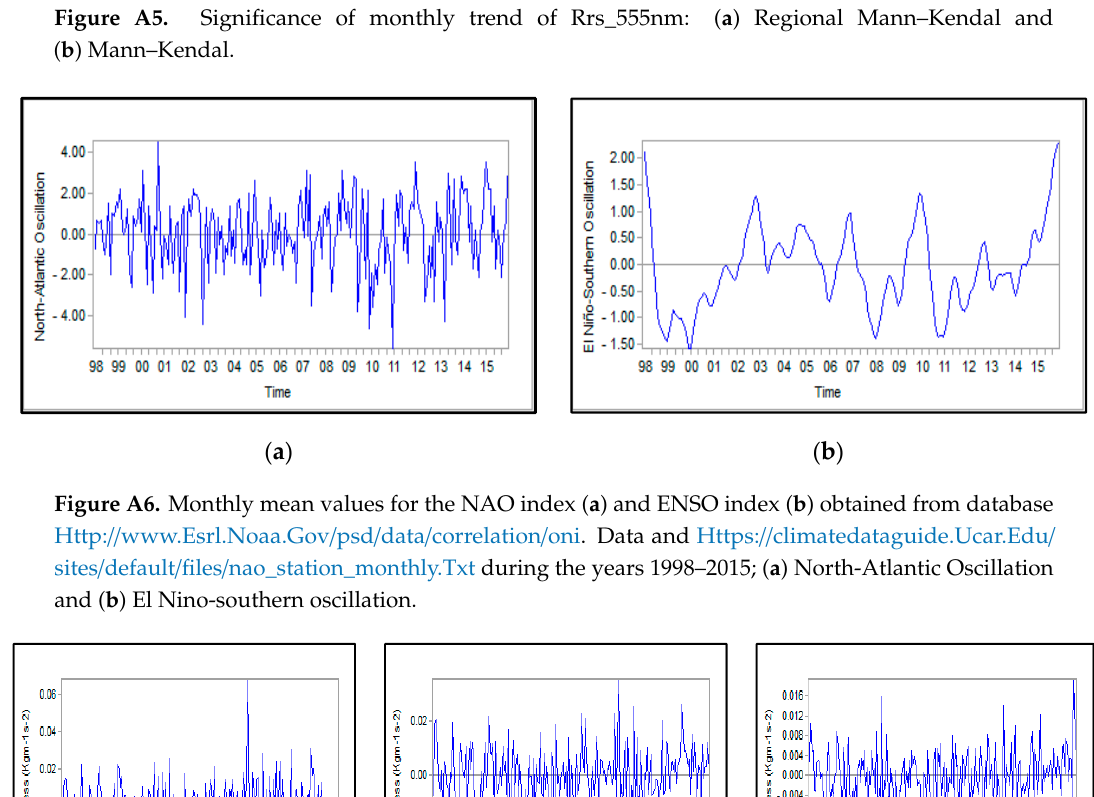
Figure A8. Monthly anomalies of the surface temperature for: ( a ) Northern, ( b ) Middle, and ( c ) Southern Caspian Sea. ( a ) ( c ) Figure A9. Monthly anomalies of the attenuation coefficient for: ( a ) Northern, ( b ) Middle, and ( c ) Southern Caspian Sea. ( a )